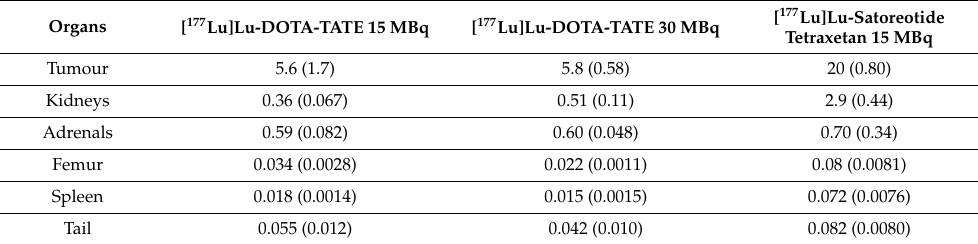
Figure 1. Biodistribution of [ 177 Lu]Lu-DOTA-TATE at 15 and 30 MBq and [ 177 Lu]Lu-satoreotide tetraxetan at 15 MBq at 96 h following the fourth injection of the radiopharmaceuticals. ( a ) Tumour, kidney, and femur radioactivity uptake expressed as mean ± standard error of the mean. * denotes p ≤ 0.05, ** ≤ 0.01, *** ≤ 0.001, and ns, non-significant. ( b ) Tumour-to-organ ratios expressed as median (range). Table 1. Biodistribution of 177 Lu-DOTA-TATE at 15 and 30 MBq and 177 Lu-satoreotide tetraxetan at 15 MBq and in AR42J pancreatic tumour-bearing mice .